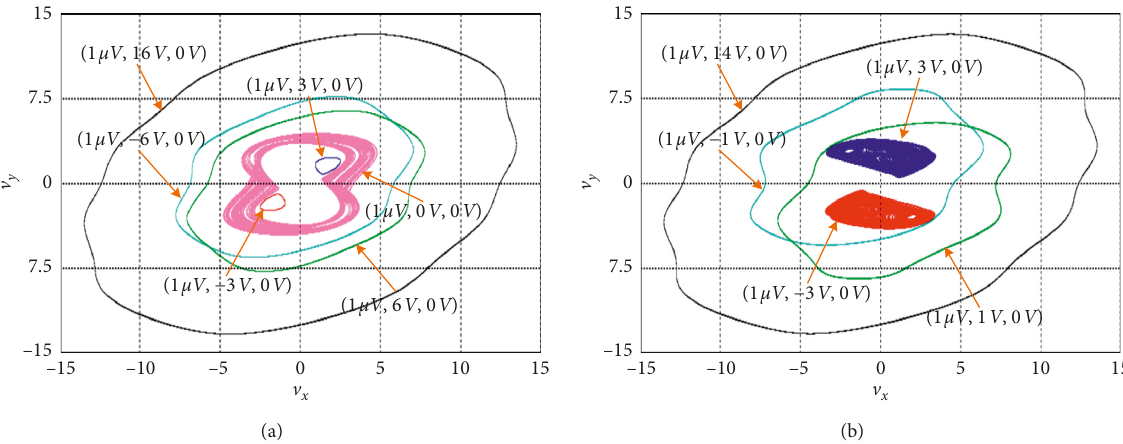
Figure 10: PSIM screen captures of coexisting multiple attractors in the v six types of coexisting multiple attractors. (b) For R k 1